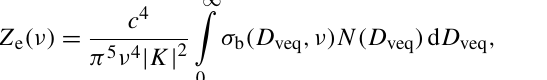
Figure 4 overviews calculated relationships between radar re- flectivity and IWC, which are used for the CloudSat inver- sions described in Sect. 3.2. Panel (a) uses the MH97 PSD, panel (b) F07T, and panel (c) D14. For MH97, the